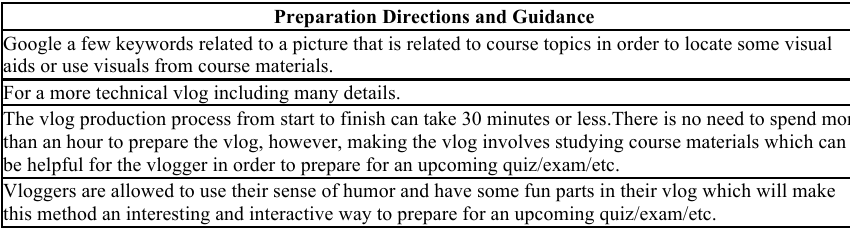
Table 1. Student-created Video Development